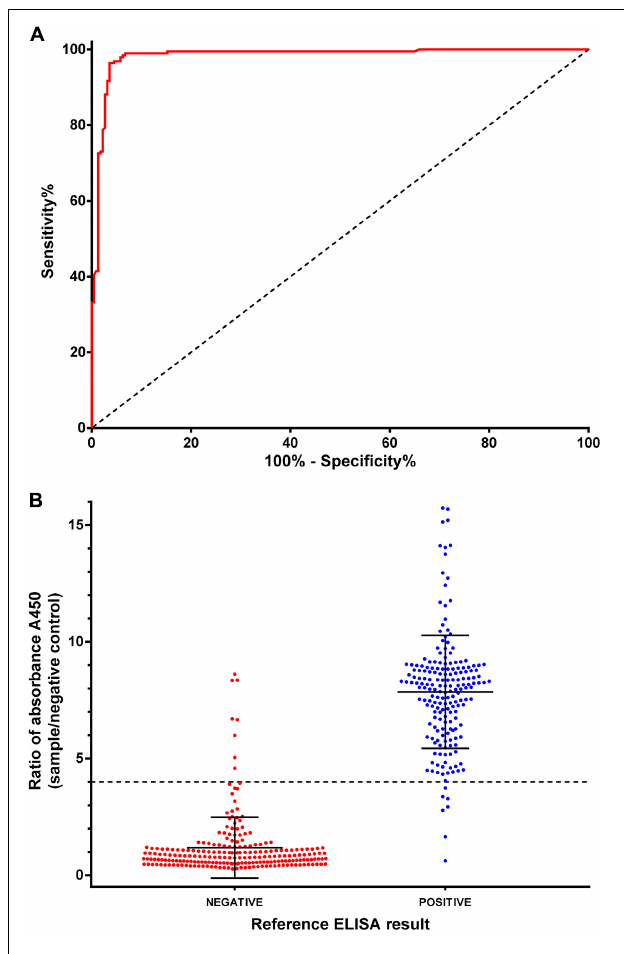
FIGURE 5 | ELISA assay validation and diagnostic performance. (A) Receiver operating characteristic (ROC) analyses of the Indirect NPC-2 ELISA in 416 human sera, positive or negative by reference ELISA (INgezim COVID-19 DR, Ingenasa). (B) Distribution of NPC-2 ELISA protocol results by sample classification (negative or positive in reference ELISA test).